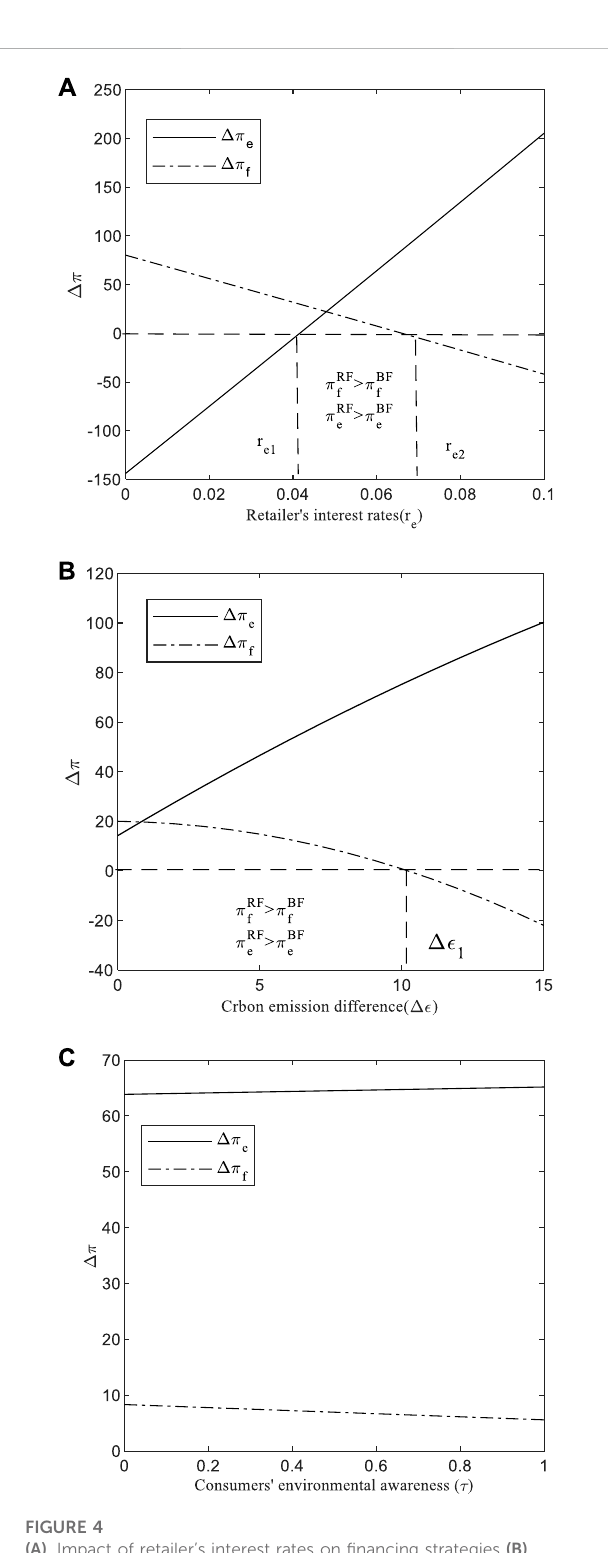
FIGURE 4 (A) . Impact of retailer ’ s interest rates on fi nancing strategies (B)